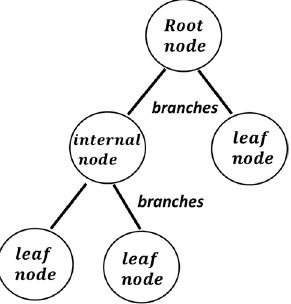
Figure 2. Decision trees.